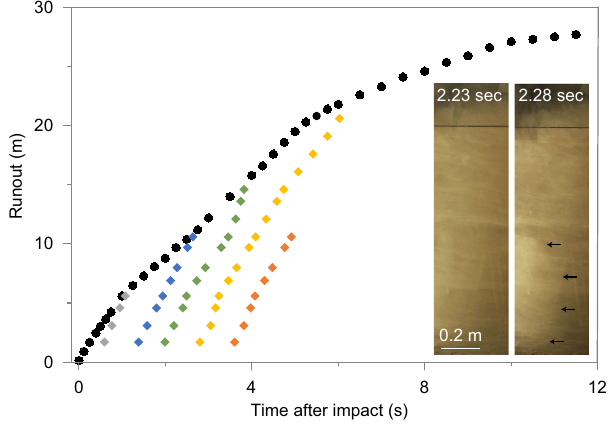
Fig. 5 Kinematics of the surge front and fl ow density discontinuities (pulses). Position of the fl ow front as a function of time (black dots) from fl ow impact to a runout distance of 28 m (datapoints for the last four meters of propagation are not shown). The positions of the fronts of the fi ve fast-travelling internal density discontinuities (pulses) as a function of time are shown as grey, blue, green, yellow and orange diamond symbols. The inset depicts two high-speed images of the lower 1.3 m of the fl ow at different time (2.23 and 2.28 s after impact). The image at 2.28 s shows the passage of a bow-shaped internal density discontinuity whose front is highlighted by black arrows. The feature stretches vertically across the entire wall region and the lower third of the jet The resulting fi eld of turbulent fl uctuations reveals the coherent turbulence structures of the experimental pyroclastic surge (Fig. 6a). Shear with the rough bed, creating the turbulent- boundary layer, and free shear of the turbulent fl ow with the uncon fi ned atmosphere generate the largest (0.9 – 1.2 m) eddies that pass at a period of c. 800 ms.